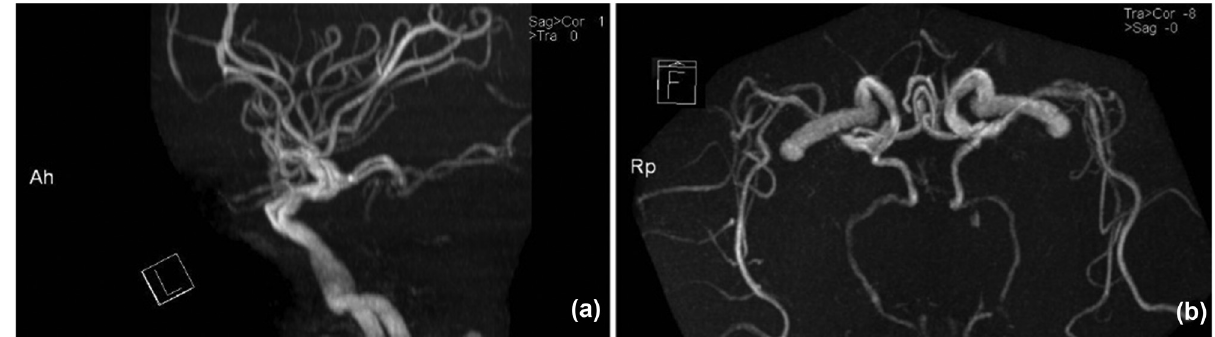
Figure 2: ( TOF - MRA imaging ) : the lateral projection of an MRA image shows the hypoplastic BAS. ( a and b ) The posterior communicating arteries supply the territory of all branches of the PCAs, which were considered as fetal - type. ( b ) Caudocranial projection image shows that both PCAs were divided from ICA